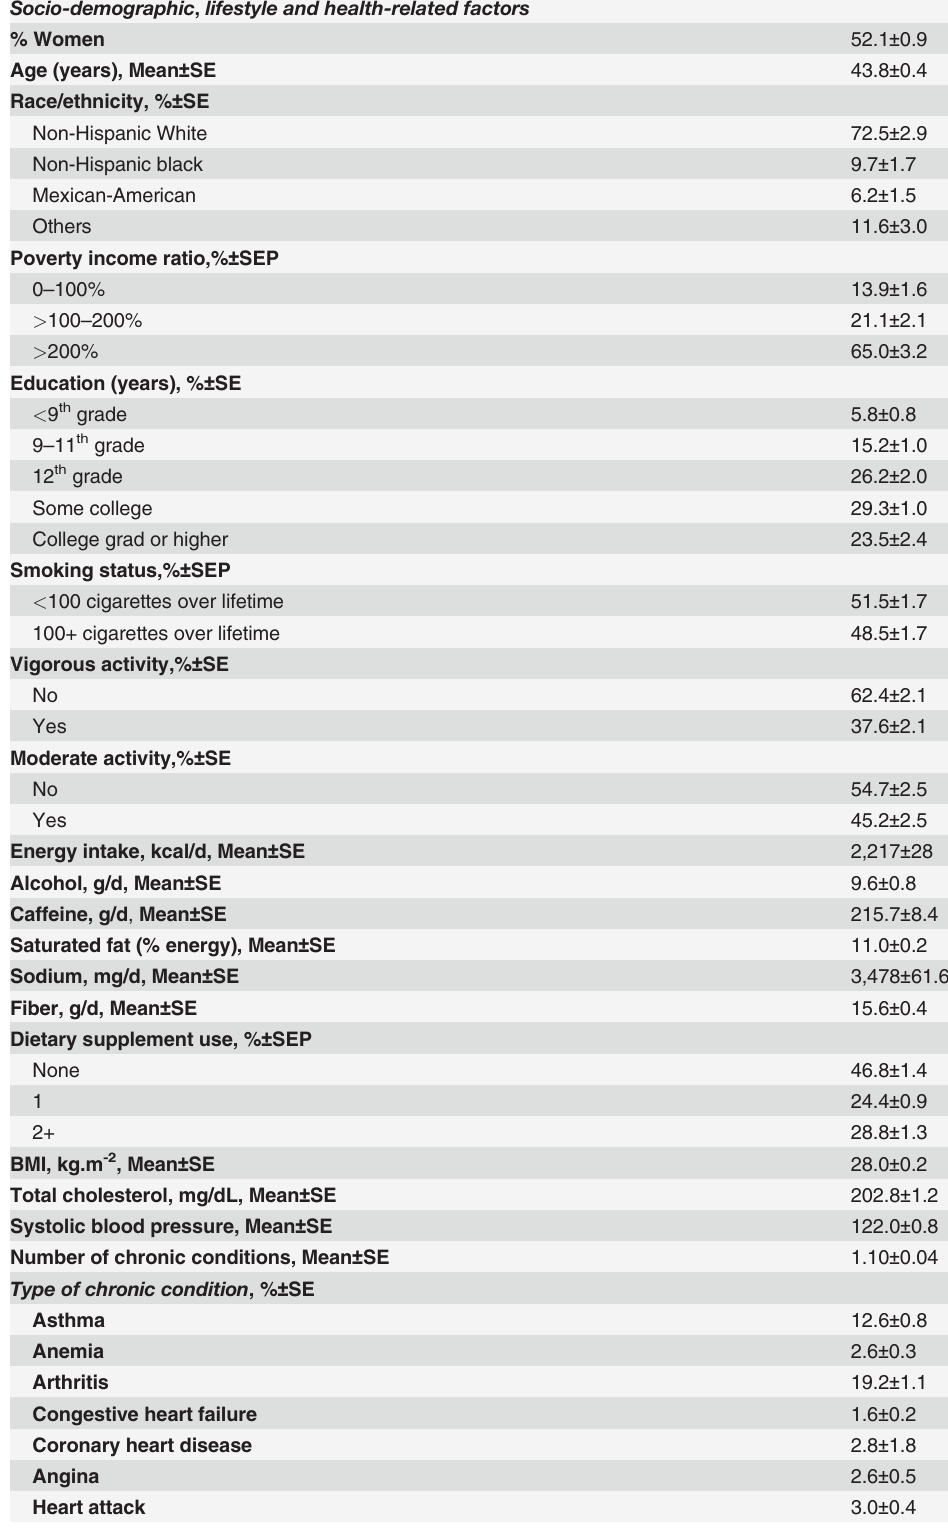
Table 2. Study sample characteristics, NHANES 1999 – 2000 (N =